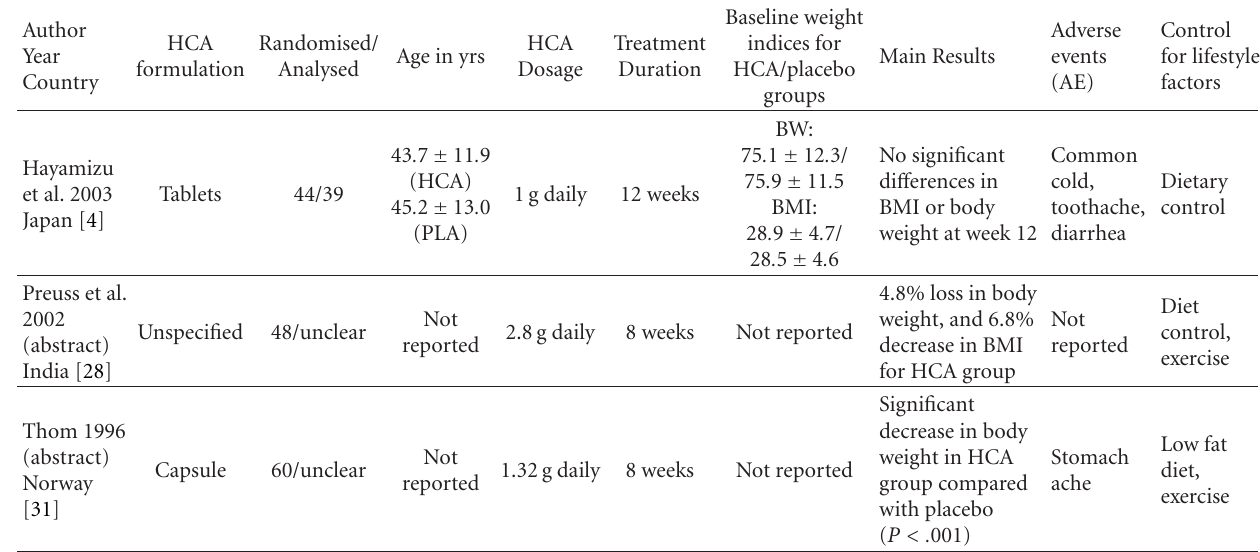
Table 3: Results of included studies without suitable data for meta-analysis .